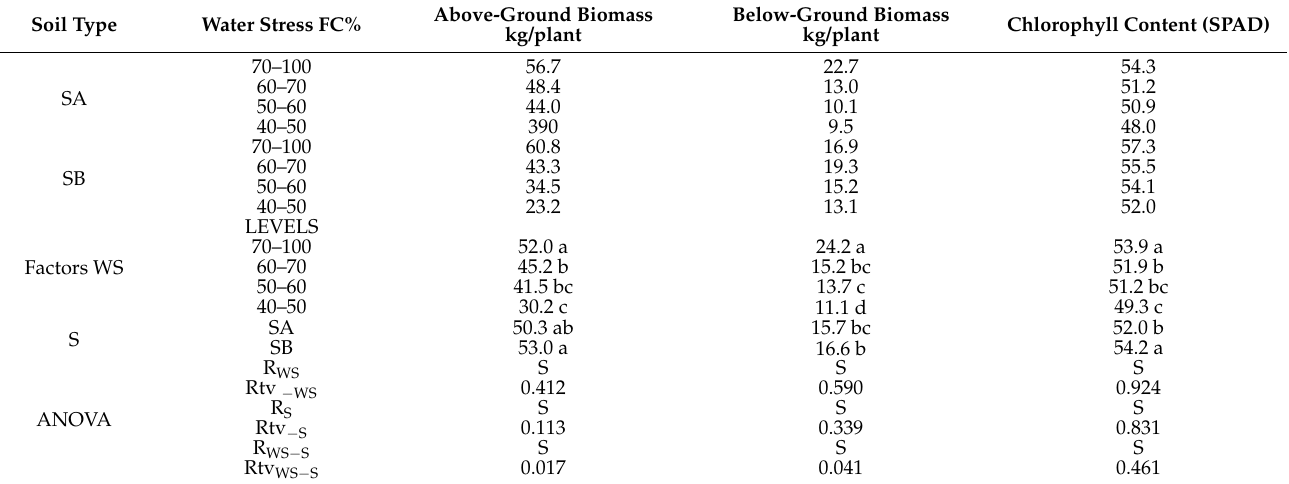
Table 7. Above-ground biomass and below-ground biomass under different water stress levels and in sandy loam (SA) and silty loam soils